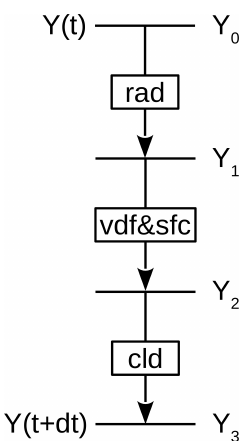
Figure 3. The forcing consists of three sequentially coupled com- ponents for radiative heating (rad), vertical diffusion (vdf) coupled implicitly to land surface processes (sfc), and cloud microphysics (cld). Each component computes its contribution to the forcing from a provisional state Y expressed in the physics variables T,m,q i ,u , and v